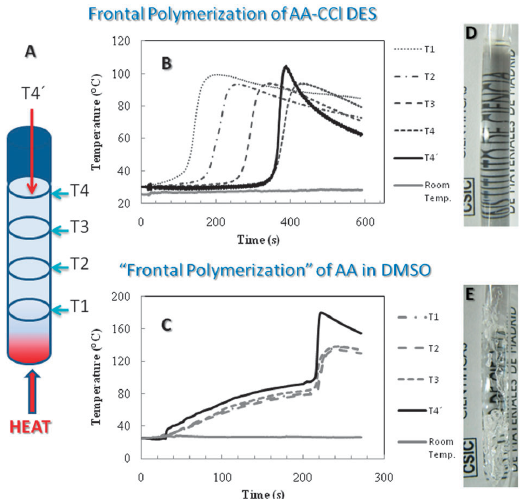
Fig. 2 Scheme representing the allocation of the thermocouples Figure 2. Frontal polymerization using a polymerizable eutectic. ( A ) schematic of the frontal (T1–T4) along the reactor (A). Plot of temperature profile of the front